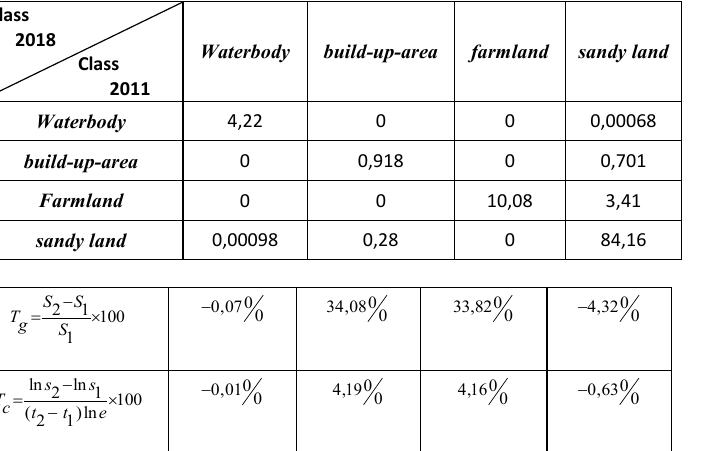
Table 4: Quantitative evaluation of land use changes during the period from 1987 to